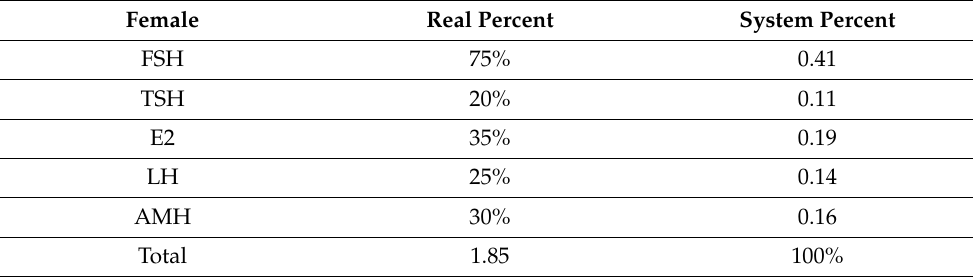
Table 2. The hormone’s effects as a percentage in real percent and system percent.